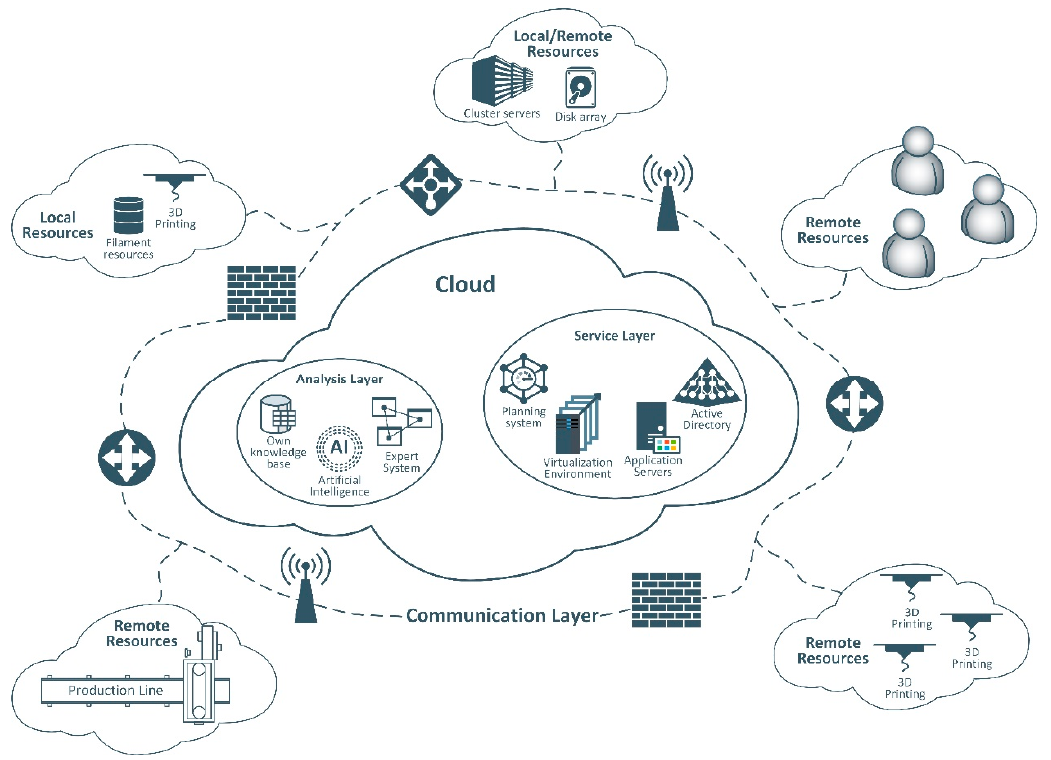
Figure 4. Remote prototyping system architecture.